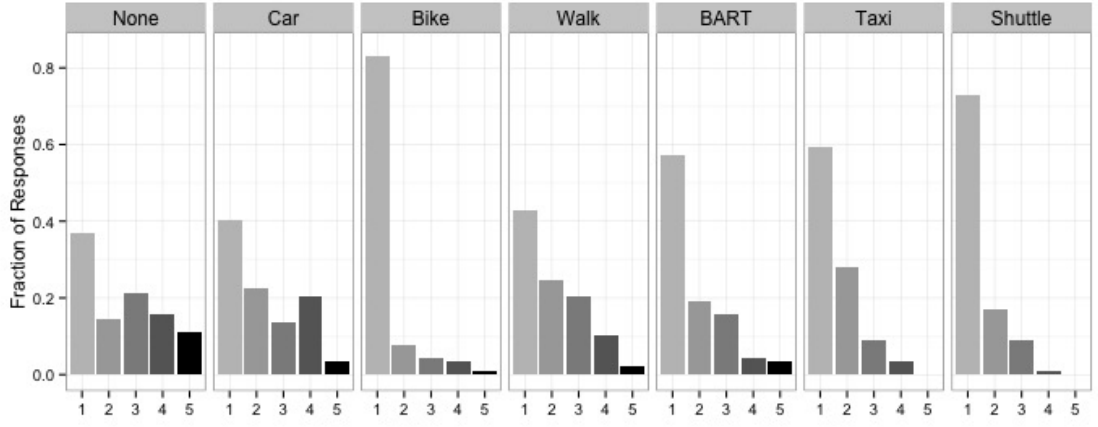
Figure 5. Decrease in Muni use: Travel modes substituted for Muni trips. (1 - applies to none of the trips, 5 - applies to all trips.)